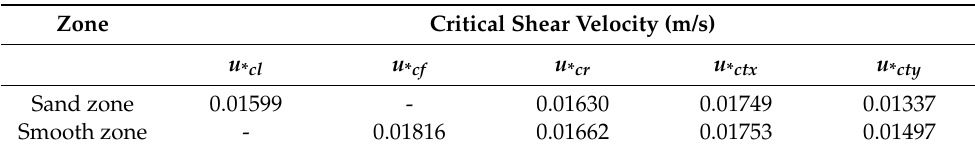
Table 4. Estimated critical shear velocity by different indirect methods.